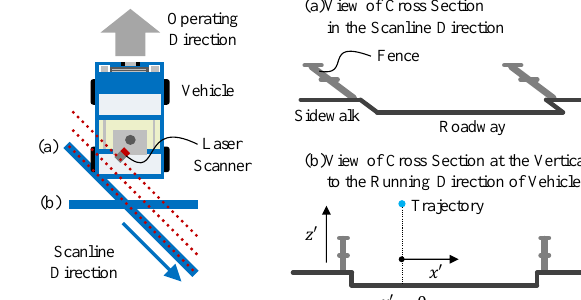
Figure 2. Point cloud projection at the